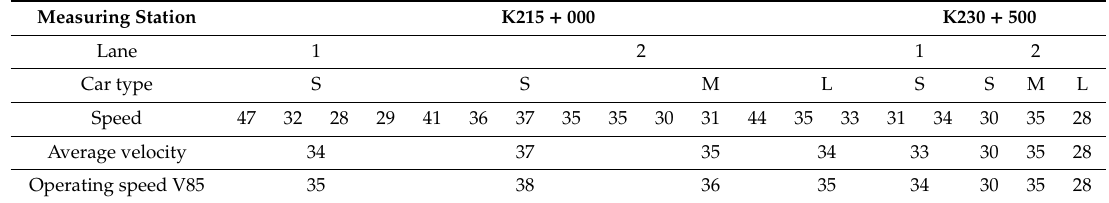
Table 5. Summary of speed measurement at each intersection (km /